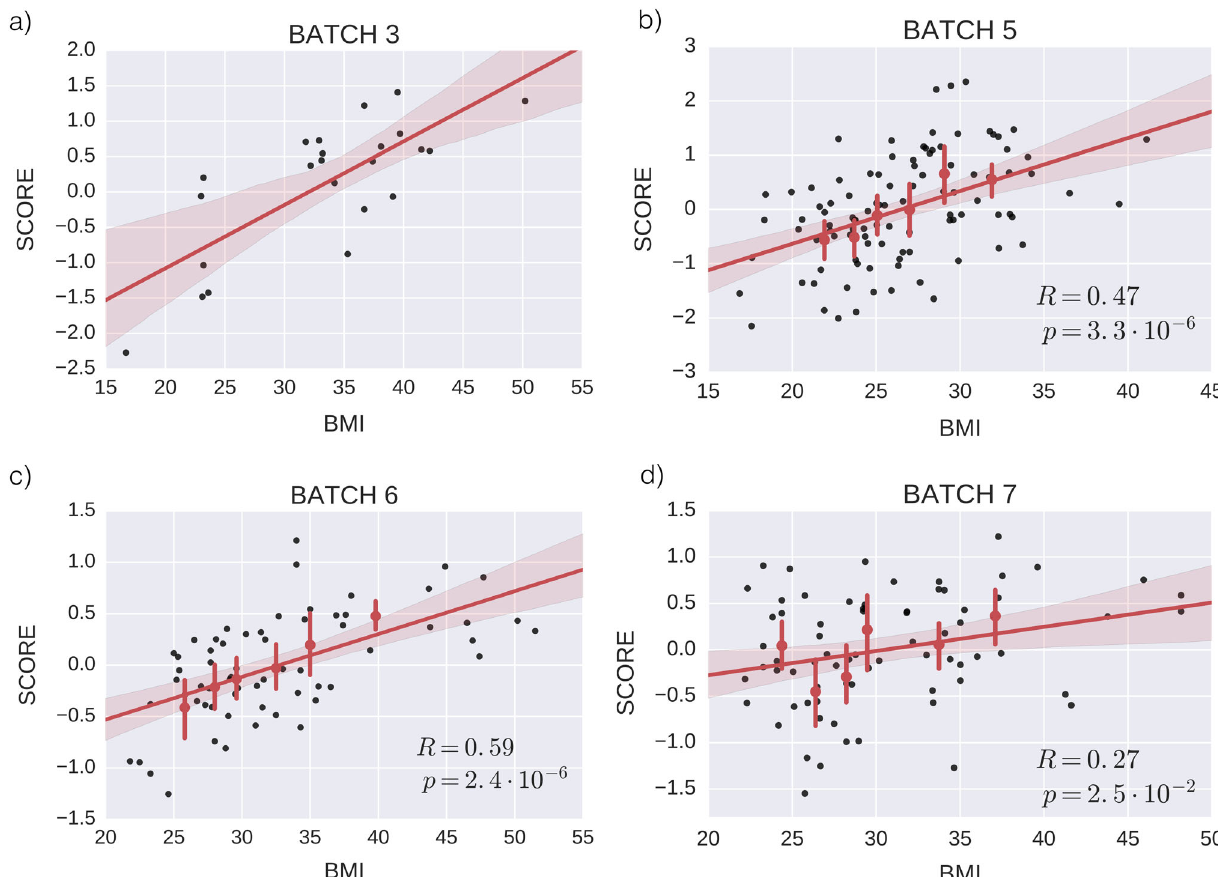
Fig. 2 The obesity score correlates with BMI. Scatter plots ( black solid dots ) and linear least-square regression fi ts ( red lines ) of the obesity score against BMI, for batch 3 a , batch 5 b , batch 6 c and batch 7 d . P -values are computed for validation data sets via two-sided null hypothesis of 0 slope. Batch 3 was also used to construct the score and is shown only as reference, while batches 5, 6, and 7 are independent validation data sets. Data is binned using percentiles and displayed with 95% con fi dence intervals (CI) red error bars , with a red dot marking the mean value of each bin. The red solid line is the fi tted regression line, and the red shaded area corresponds to 95% CI of the regression line, computed via